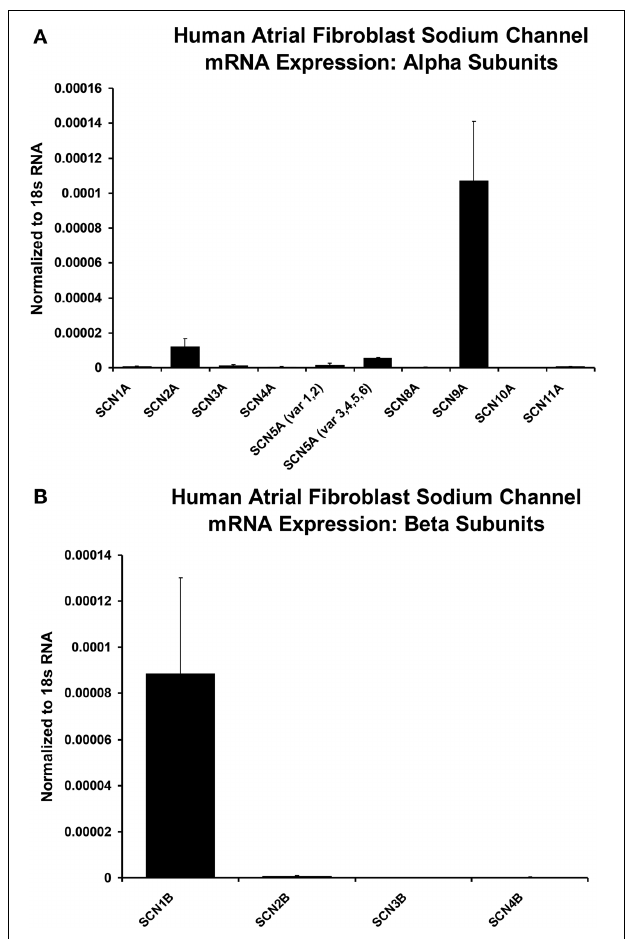
FIGURE 5 | Histograms of normalized data from PCR measurements of relative levels of Na + channel α and β subunits, based on RNA derived from populations of isolated human atrial myofibroblasts maintained in 2-D tissue culture. Note from panel (A) the predominant α subunits are SCN9A and SCN2A; Panel (B) shows that the strongest β subunit signal is for β 1 . However, the cardiac isoform of Na + current α subunit, SCN5A, also can be detected (see Discussion). Sample size for mRNA measurements are from n = 3 individual samples for plated and collagen treated fbs (only plated values are shown). The statistical analysis was based on the difference between plated and collagen treated cells, with a simple unpaired t -test to compare gene expression under the two